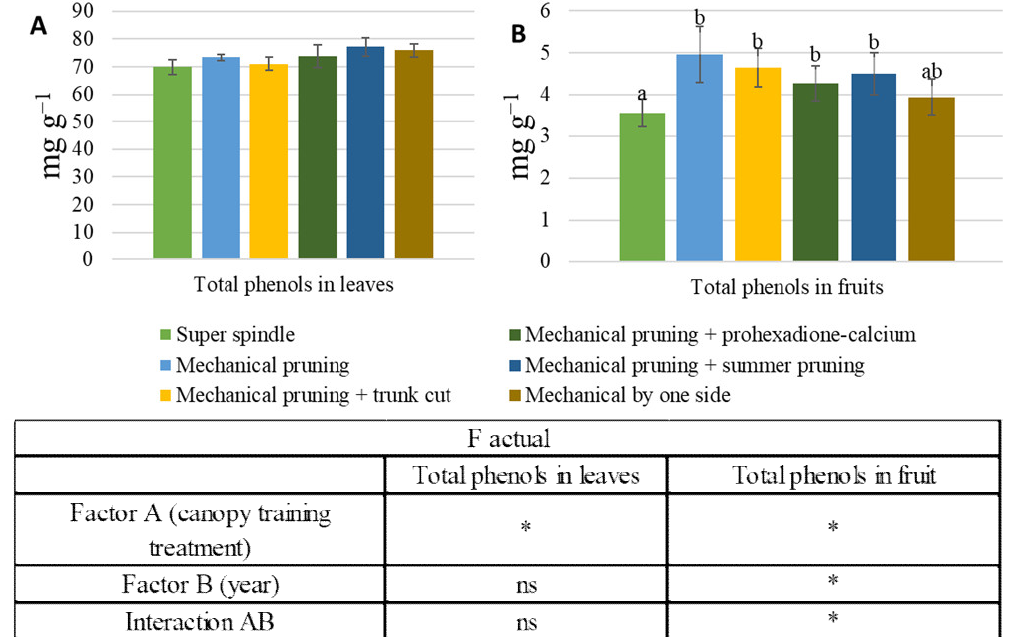
Figure 3. The effect of canopy training treatments on total phenols in cv. Rubin leaves ( A ) and fruits ( B ) at BBCH 87–88. The mean value of three years ( n = 3 × 3 = 9) ± standard deviation is presented. The data were processed using a two-way analysis of variance (ANOVA), the Tukey (HSD) test at the confidence level p = 0.05. The different letters in blocks indicate significant differences in treatment, LSD–Fisher’s protected least: * p < 0.05; shows significant differences, ns—no significant differences.